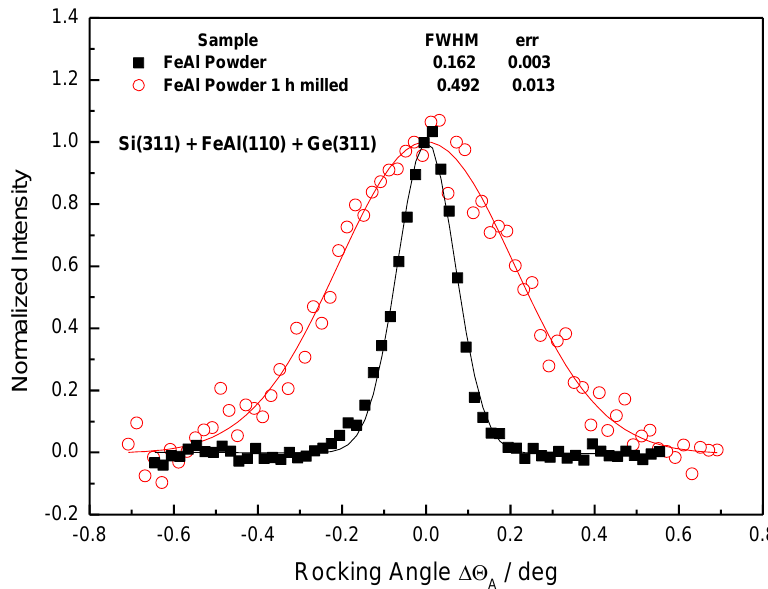
Figure 11. Analyzer rocking curves for the Fe28Al initial powder and the Fe28Al 1-h milled powder.